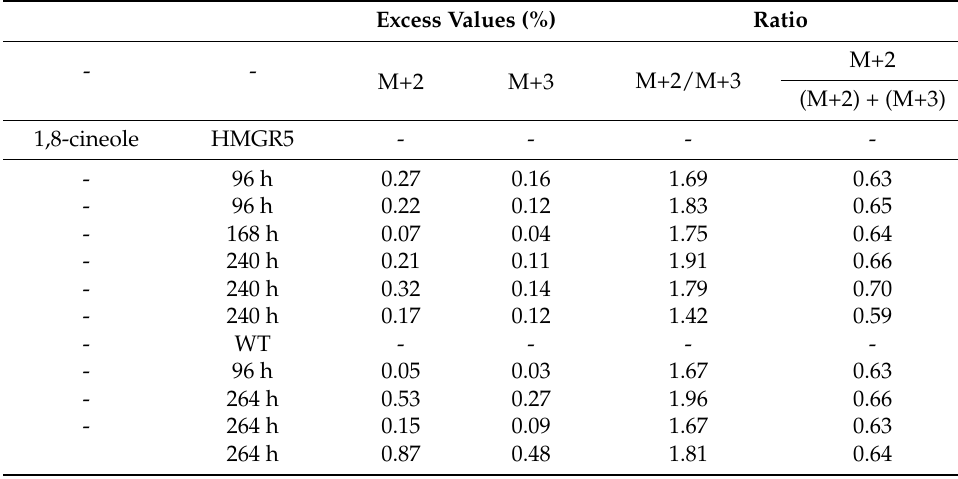
Table 7. GC/MS excess data for M+2 and M+3 isotopomeres in 1,8-cineole extracted with chloroform-d and analyzed by GC/MS from spike lavender leaves from lines HMGR5 and WT at different points of time after the labelling pulse phase with 13 CO 2 . h: